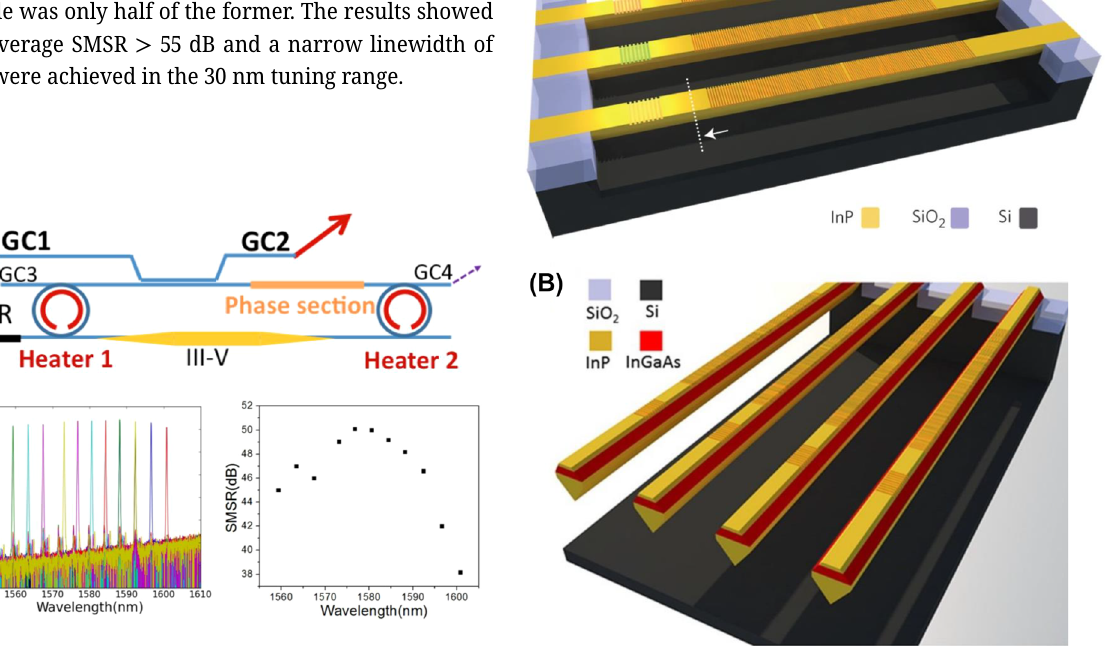
Figure 7: (A) Monolithically integrated InP DFB lasers on silicon [54]. (B) Monolithically integrated InGaAs/InP DFB lasers on silicon